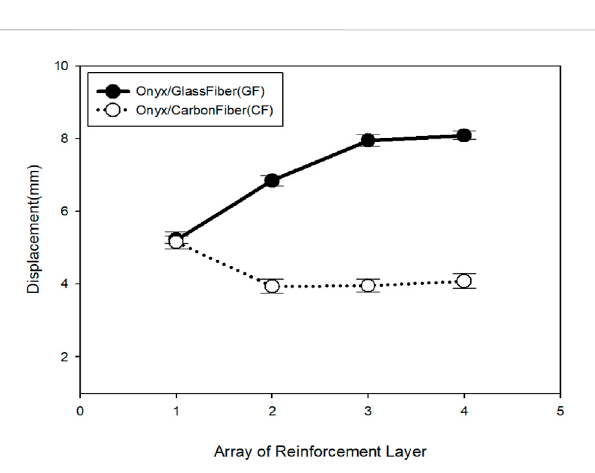
FIGURE 4 Specimen displacement according to the type of reinforcement and number of